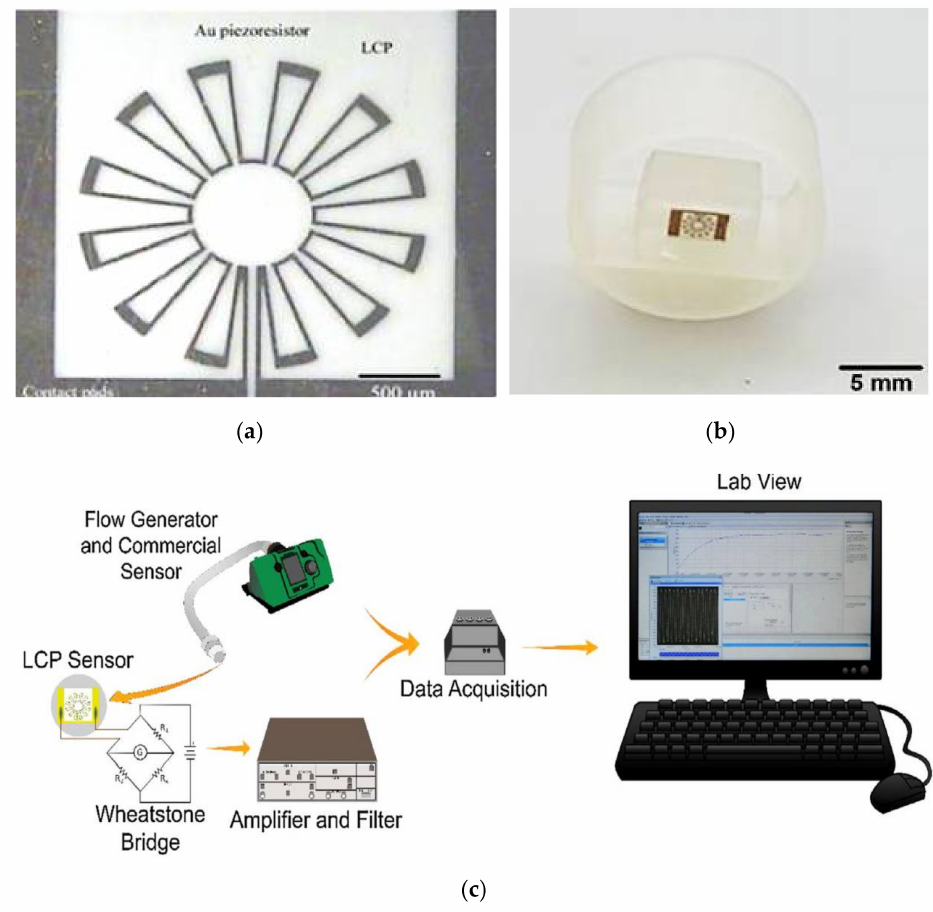
Figure 4. LCP flow sensor proposed in [55] ( a ); a 3D printed housing was developed to package the sensor in the flow generator tube ( b ). Experimental setup used to test LCP flow sensor, where this last is connected to the flow generator, filter/amplifier, and data acquisition devices ( c )